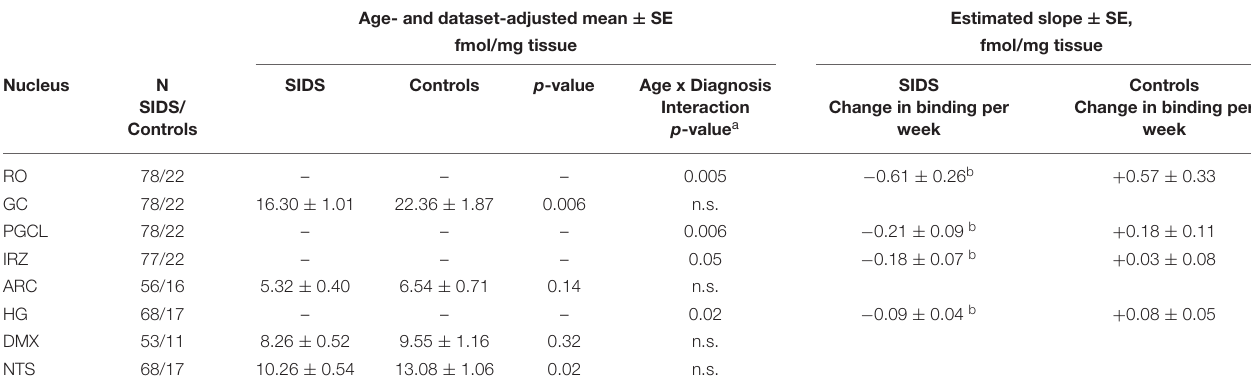
TABLE 2 | 5-HT 1A receptor binding in the medullary serotonin system in a combined cohort of SIDS and